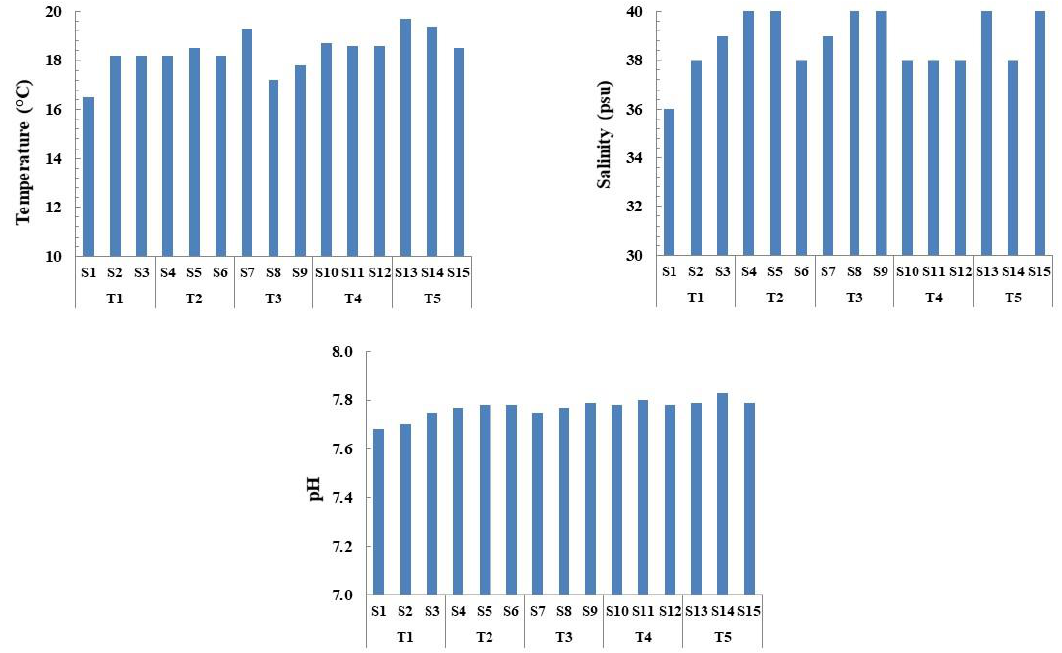
Figure 2. Spatial variation of temperature, salinity, and pH at sampled stations (S1 – S15), divided according to transects (T1 – T5). Table 1. Mean values (Standard Deviation) of physico-chemical and biological parameters of 5 tran- sects sampled in the coastline of the Gulf of Gab è s. In the last column are results of one-way ANOVA for the comparison between the five sampled transects followed by Tukey’s post hoc